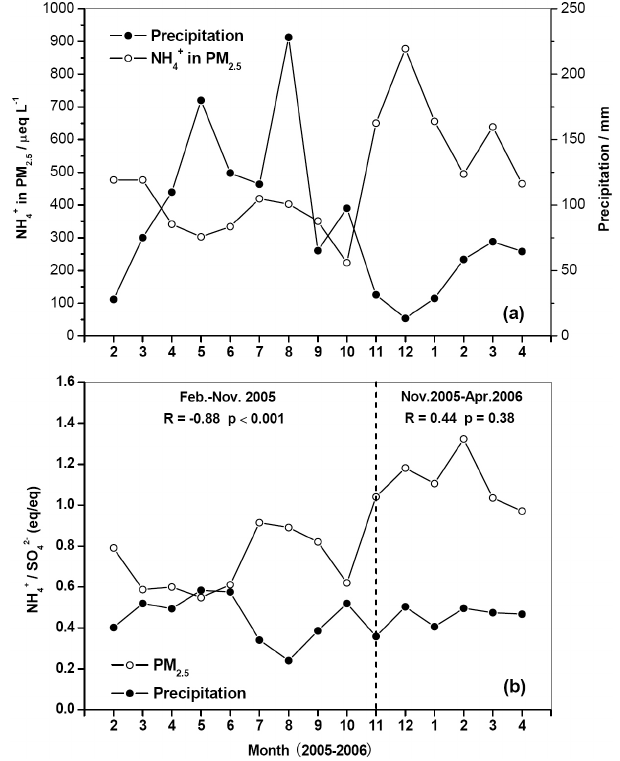
Fig. 7. Monthly variations of (a) amount of precipitation vs. con- centration of NH + in PM 2 . 5 and (b) equivalent charge ratios of 4 NH + /SO 2 − in PM 2 . 5 vs. precipitation at Chongqing from Febru- 4 4 ary 2005 to April